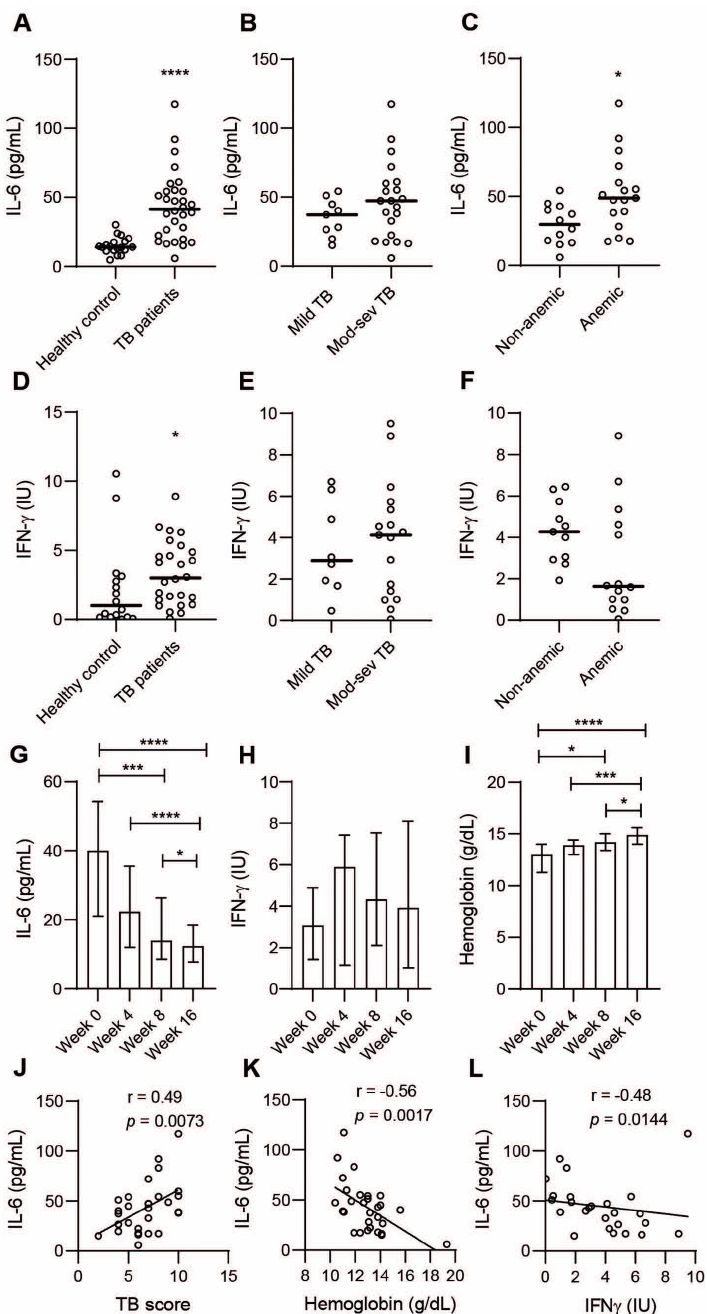
Figure 5. Peripheral IL-6 ( A – C ) and IFN- γ ( D – F ) levels in TB patients ( n = 30) and healthy con- trols ( n = 19) and in different sub-groups of TB patients. Longitudinal changes in ( G ) IL-6 levels, ( H ) IFN- γ levels, and ( I ) blood Hb levels in the TB patients at weeks zero (baseline), four, eight, and 16. Correlation analyses between IL-6 and ( J ) the clinical TB score, ( K ) blood Hb, and ( L ) IFN- γ levels as determined using Spearman ´ s correlation test. Data (median) from placebo-treated TB patients ( n = 30) are shown in scatter plots and were analyzed using a Mann–Whitney test, p < 0.05 *, p < 0.0001 ****, while longitudinal data (median ± IQR) are shown in bar graphs and were analyzed using a Friedmans test, p < 0.05 *, p = 0.0001 ***, p < 0.0001